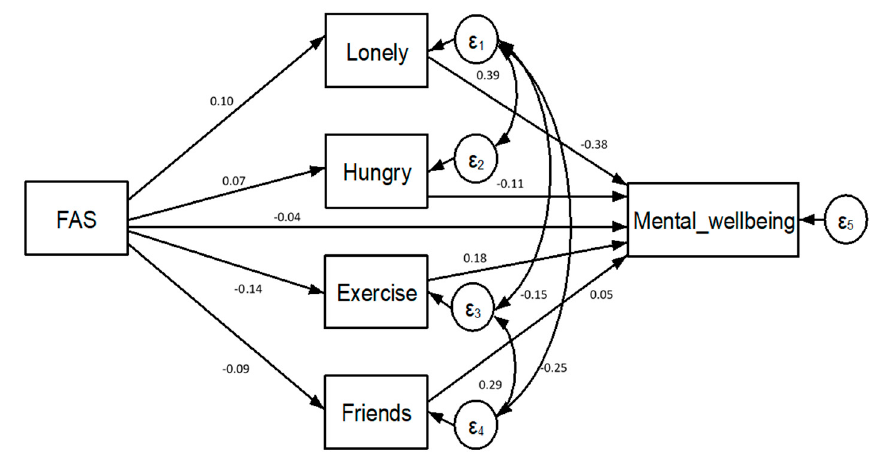
Figure 1. Model 1, which was the Short Warwick-Edinburgh Mental Wellbeing Scale